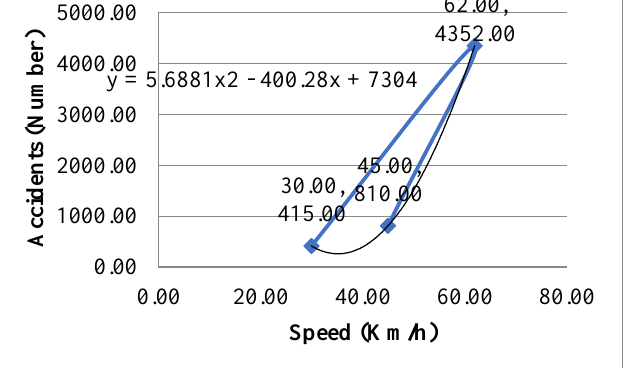
Fig. 9. Speed vs. accident data